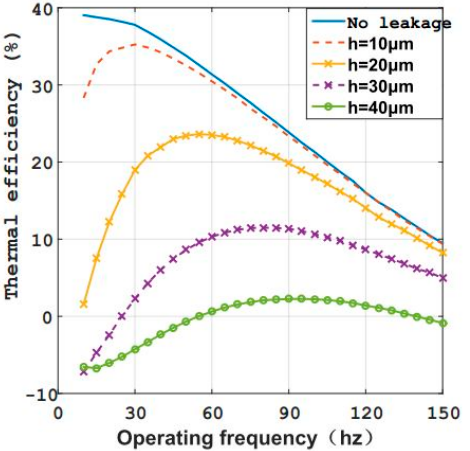
Figure 22. Engine efficiency vs. frequency under different gap heights.